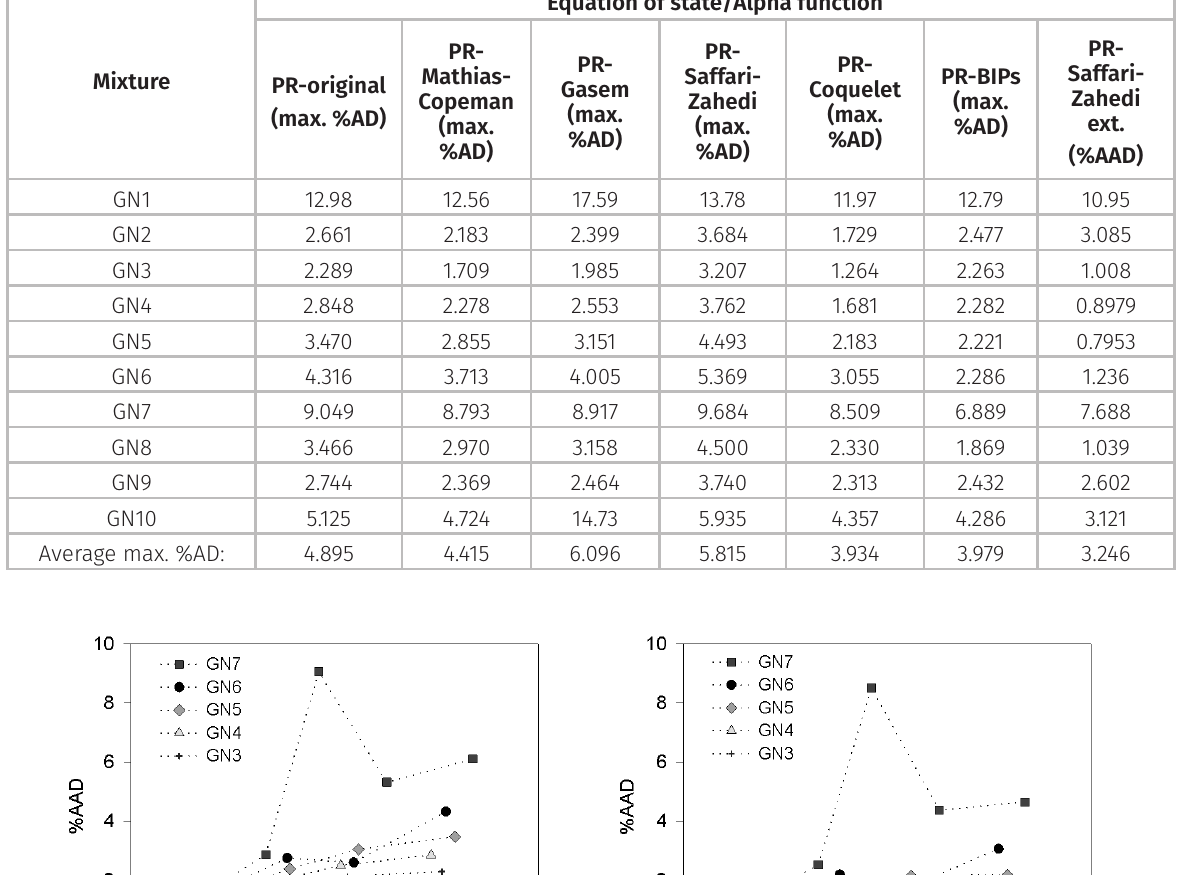
Table VIII. Maximum deviations between experimental and calculated molar volumes.